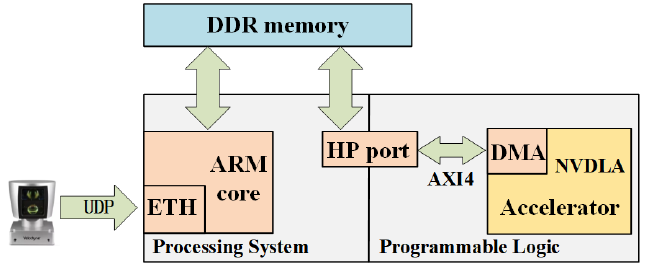
Figure 8. Overall system setup with LiDAR connected to the FPGA board directly.